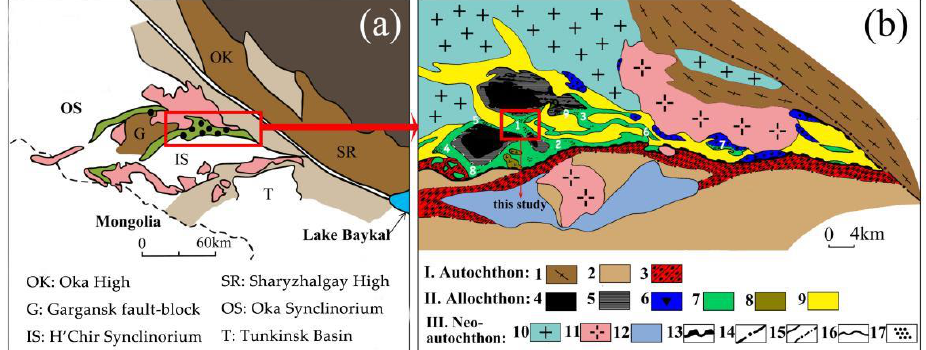
Figure 1. ( a ) Geological setting of ophiolites of the East Sayan belt. ( b ) Structure-associational sketch of the eastern part of the East Sayan ophiolite belt (Adapted from Prokhor, 1991) [10]. I Autochthon: (1) Crystalline formations on the margin of the basement highs of the Siberian platform; (2) carbonate association; (3) tectonites at the base of the nappe. II Allochthon: (4) dunite–harzburgite complex; (5) chrysotile–antigorite serpentinite; (6) olivinized serpentinite; (7) chrysotile–lizardite serpentinite of mélange zones; (8) metavolcanics; (9) schists. III Neo-autochthon: (10) diorite and plagiogranite; (11) granite and alkaline granite; (13) thrust at base of nappe; (14) major faults; (15) tectonic contacts between members of the ophiolite association; (16) stratigraphic and intrusive contacts; (17) sectors of concentration of nephrite veins (nephrite deposits and prospects). The numbers represent mines: 1: Ospinsk; 2: Gorlykgol’; 3: Bortogol’; 4: Sagansair; 5: Zunospinsk; 6: